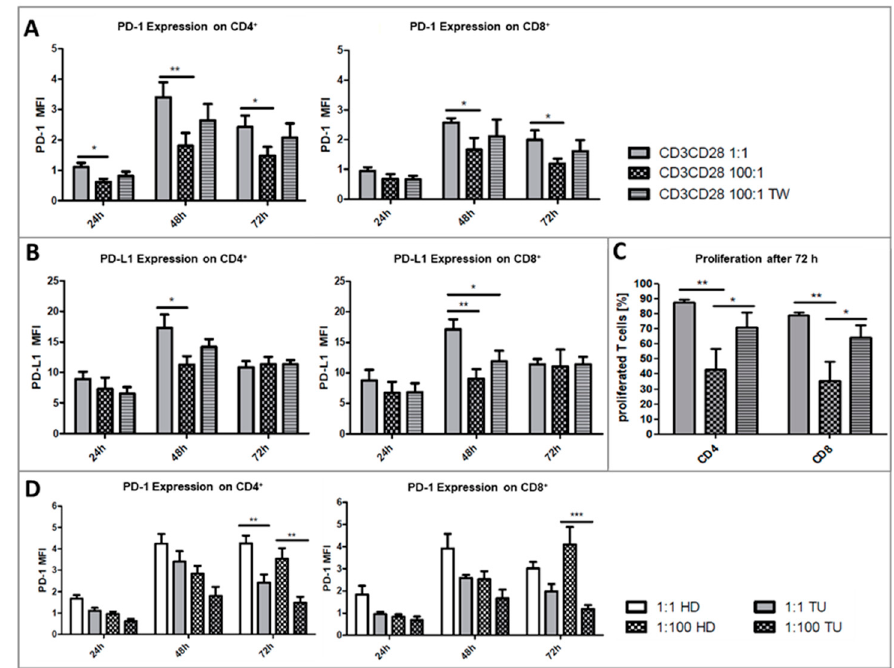
Figure 7. Flow cytometric analysis of the PD-1 ( A ) and PD-L1 ( B ) expression levels on CD4+ or CD8+ T cells from head and neck cancer (HNSCC) patients after 24, 48, and 72 h of culture. Cells were stimulated with anti-CD3 and anti-CD28 antibody and cultured in a PLT: PBMC ratio of 1:1, 100:1 or 100:1 in Transwell Assays. ( C ) Percentage of proliferated CD4+ or CD8+ T cells after 72 h anti-CD3 and anti-CD28 stimulated culture. Bars show always mean + SEM of results from 7 HNSCC patients. * p ≤ 0.05; ** p ≤ 0.01; 1-way Anova with Tukey’s multiple comparisons test. ( D ) PD-1 expression level on CD4+ or CD8+ T cells from healthy donors vs. HNSCC patients after 24, 48, and 72 h of culture. Cells were stimulated with anti-CD3 and anti-CD28 antibody and cultured in a PLT: PBMC ratio of 1:1 or 100:1. Bars show mean + SEM of results from 20 healthy donors and 7 HNSCC patients. * p ≤ 0.05; ** p ≤ 0.01; *** p ≤ 0.001; 1-way Anova with Tukey’s multiple comparisons test.